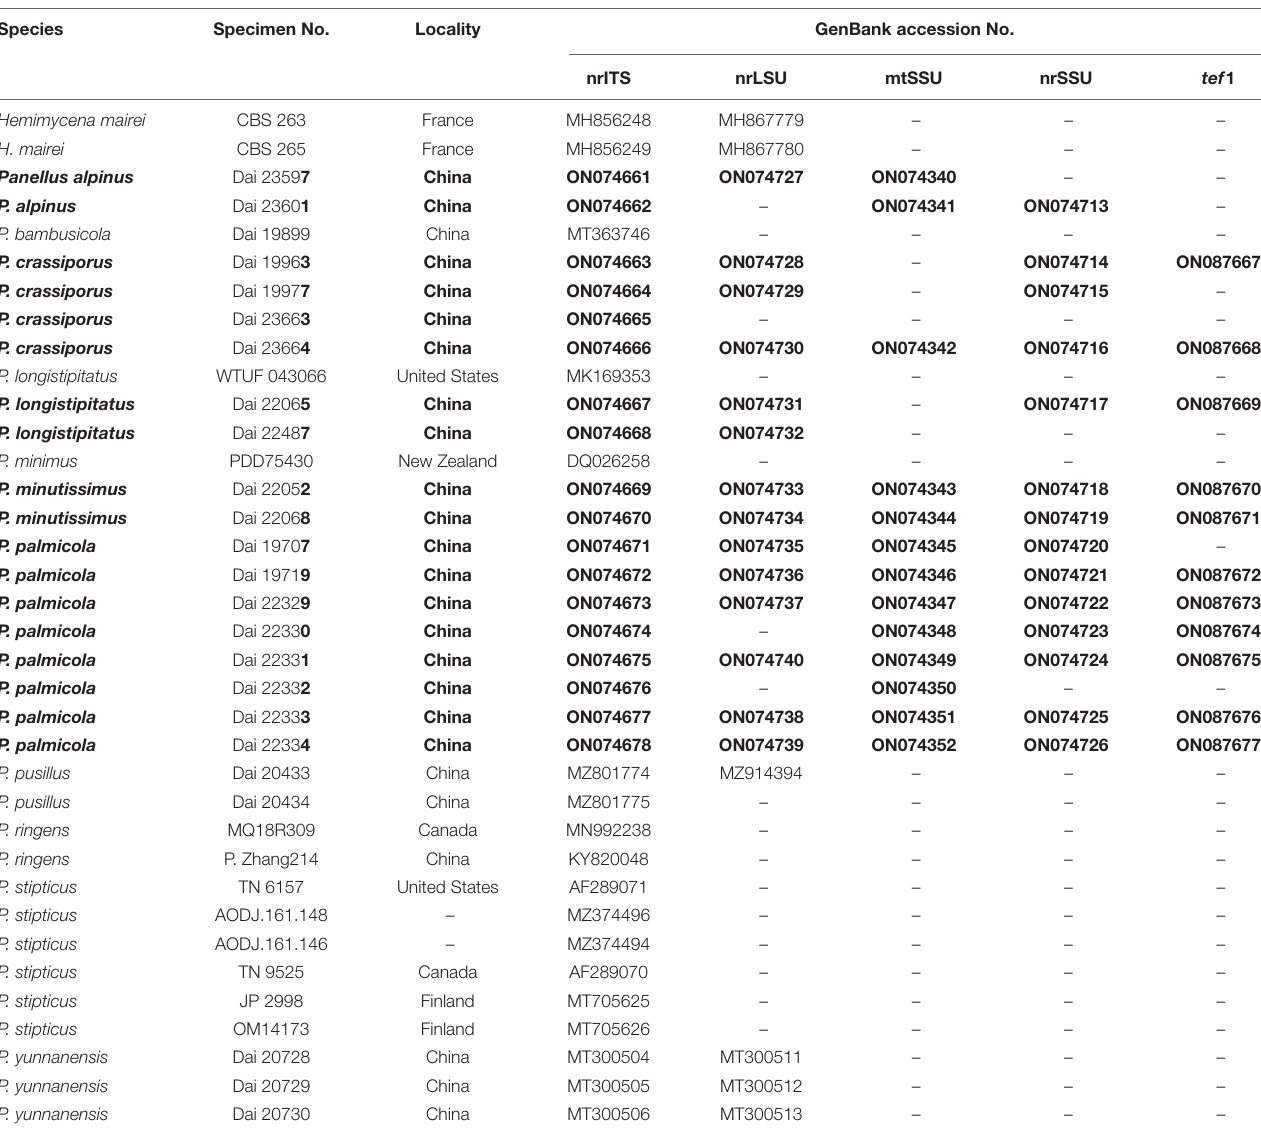
TABLE 1 | Taxa information and GenBank accession numbers of sequences used in this study. Species Specimen